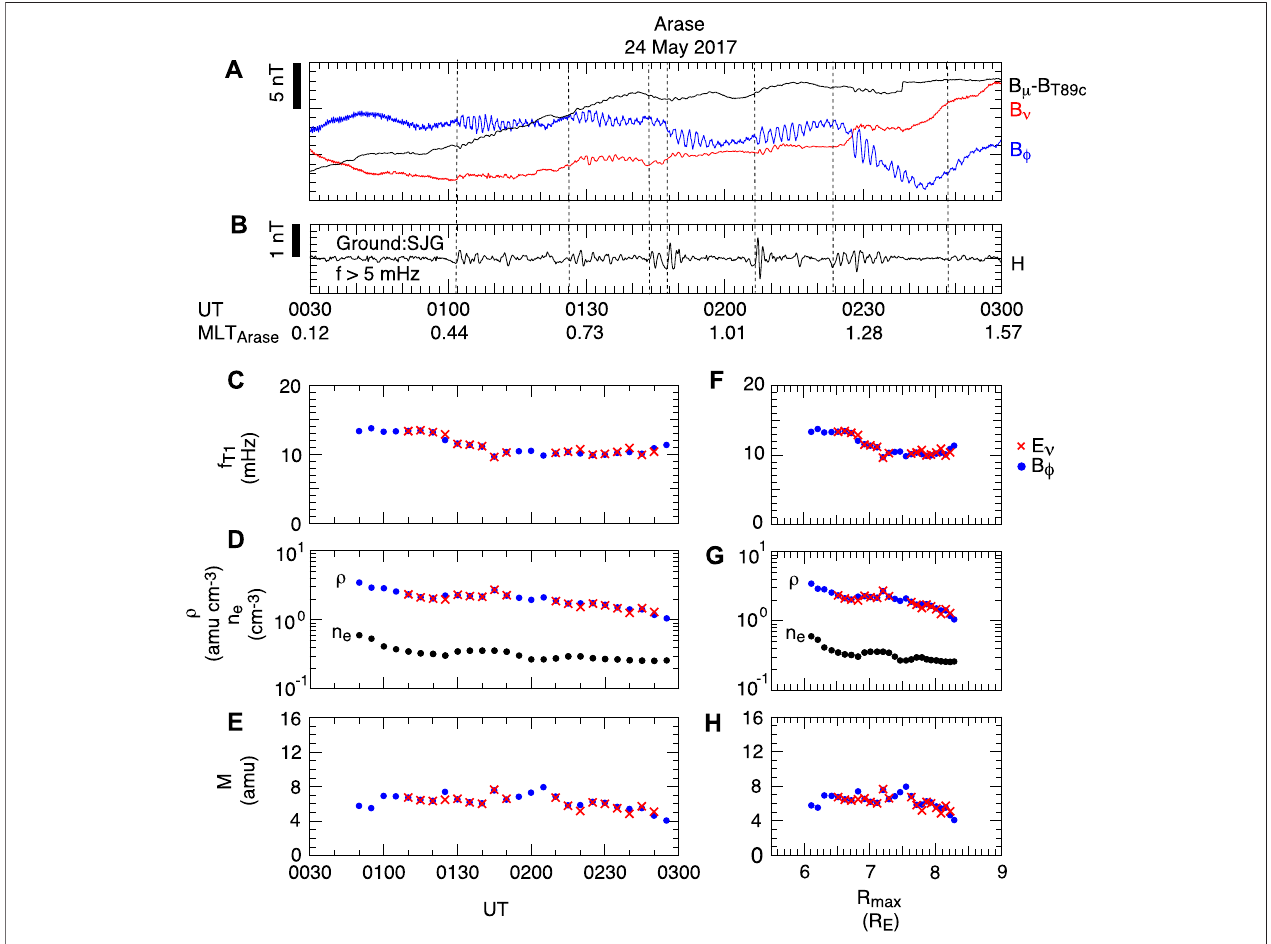
FIGURE 11 | Magnetoseismic analysis of toroidal waves detected by the Arase spacecraft in the midnight sector (after Takahashi et al., 2018). (A) Magnetic fi eld components in a magnetic- fi eld-aligned coordinate system based on the T89c magnetic fi eld model (Tsyganenko, 1989). Fundamental toroidal waves are visible in the B ϕ component. (B) High-pass- fi ltered ground magnetic fi eld H component at San Juan. The dashed vertical lines indicate Pi2 onsets. (C) Frequency of the fundamental toroidal waves. The color indicates the source fi eld component. (D) Mass density derived from the wave frequency and the electron density determined from plasma wave spectra. (E) Average ion mass. (F – H) Same quantities as in (C – E) but plotted as a function of the maximum geocentric distance to the model fi eld